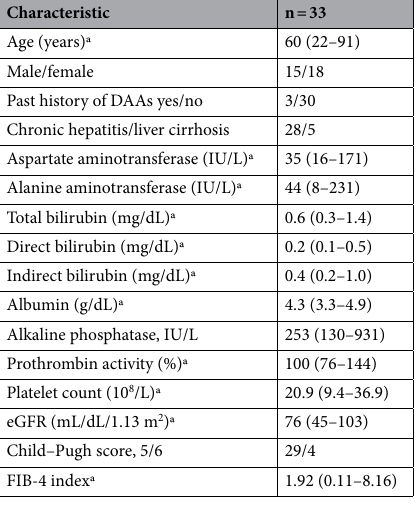
Table 1. Patients’ characteristics. eGFR estimated glomerular filtration rate, DAA direct acting antivirals, FIB- 4 fibrosis-4. a Data are shown as median (range)